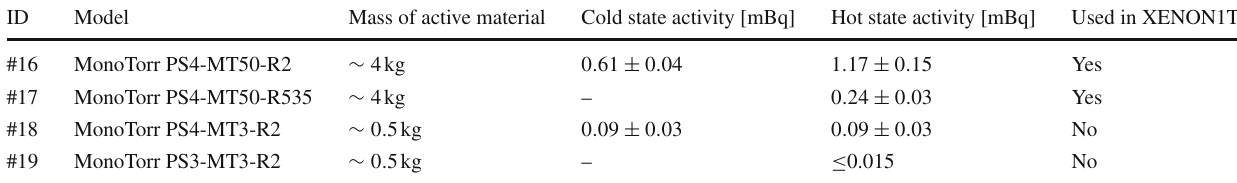
Table 3 222 Rn emanation rates of four noble gas purifiers from the company SAES. PS4-MT50-R535 is identical to PS4-MT50-R2, but received